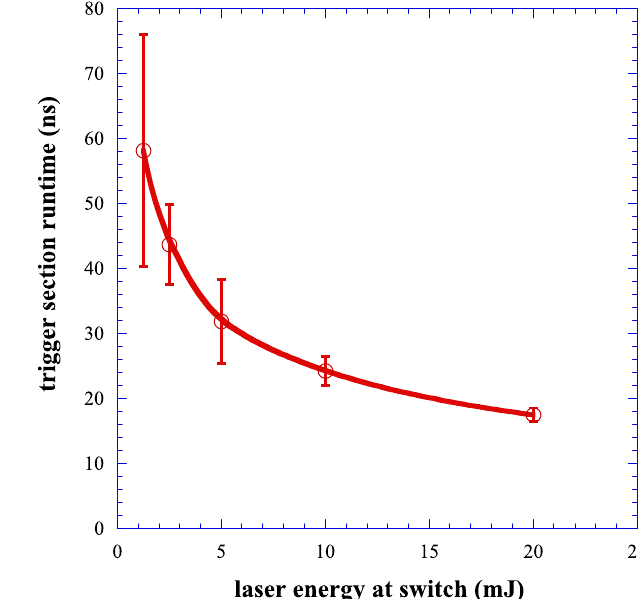
17. (Color) Example voltage traces from the diagnostics